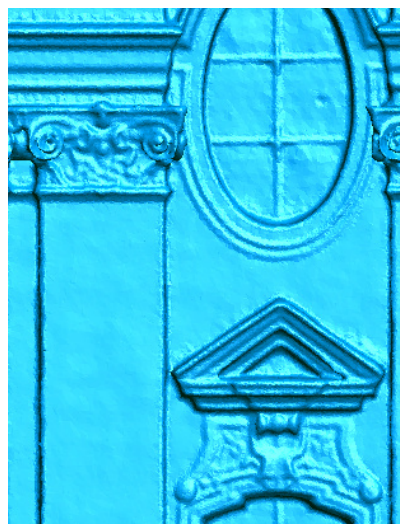
Figure 4. Mesh detail